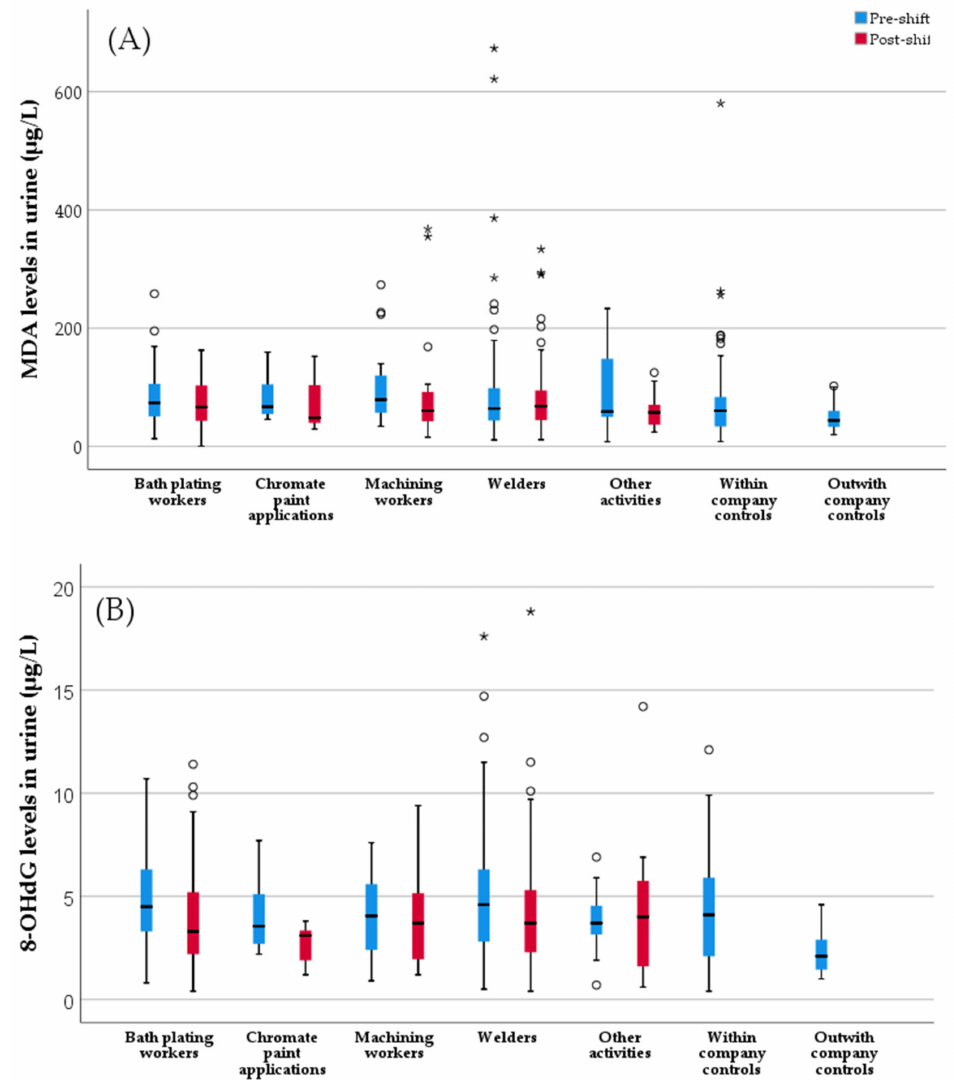
Figure 2. Levels of ( A ) malondialdehyde (MDA) and ( B ) of 8-hydroxydeoxyguanosine (8-OHdG) in pre- (in blue) and post-shift (in red) urine samples from groups of workers that were exposed to Cr(VI) and controls. * Extreme values; o